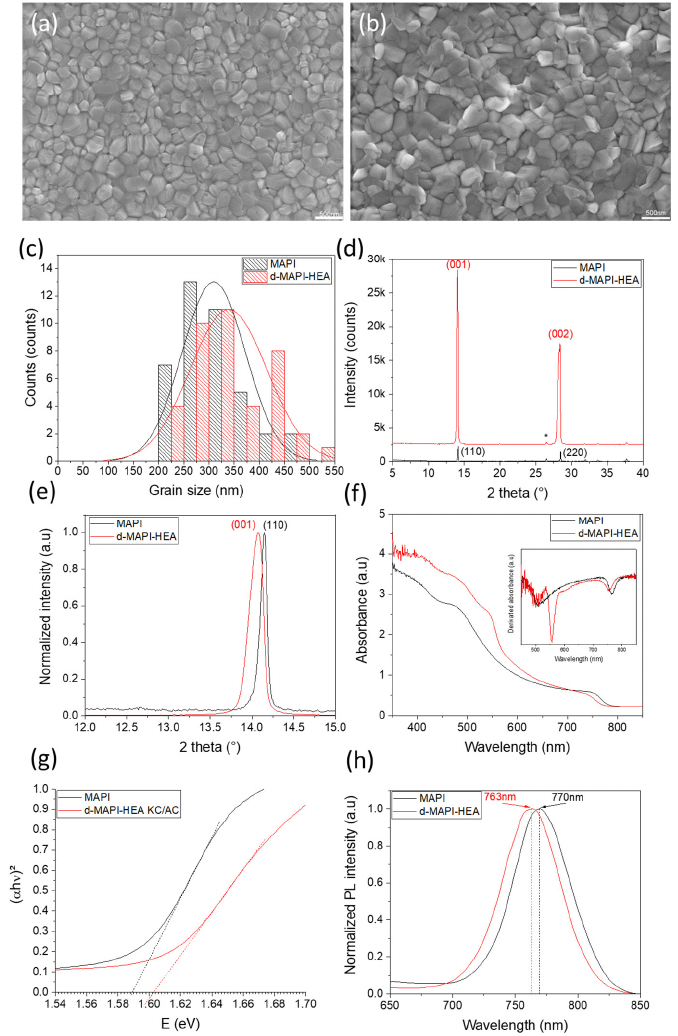
Figure 2. Top-view SEM images of ( a ) MAPI film and ( b ) d-MAPI-HEA film (Scale bar: 500 nm). ( c ) Grain size distribution in MAPI and d-MAPI-HEA films. ( d ) XRD patterns of MAPI and d-MAPI-HEA films (FTO peaks are indicated by the * symbol) ( e ) Same as ( d ), normalized and zoomed on (110) peak. ( f ) UV-Visible absorbance spectra (inset represents the derivative absorbances), ( g ) Tauc Plot, and ( h ) Steady-State PL of MAPI and d-MAPI-HEA perovskite films (λ exc = 510 nm). Once the systems were fully characterized and optimized, we fabricated complete solar cells and measured their efficiencies (12 for each system). The d-MAPI-HEA system reached its best PCE at 11.47%, with V OC = 1.06 V, J SC = 19.36 mA.cm − ², and FF = 55.76%, measured on the reverse scan, and a hysteresis index of 23.1% ( PCE = 8.82% on the forward scan). As a comparison, its classic analog MAPbI 3 delivered a maximum efficiency of 18.94 %, with V OC = 1.04 V, J SC = 22.29 mA.cm − ², FF = 81.44%, and a hysteresis index of 14.5% ( PCE = 16.20% on the forward scan) (Table S2, Supporting Information). Figure 3a displays